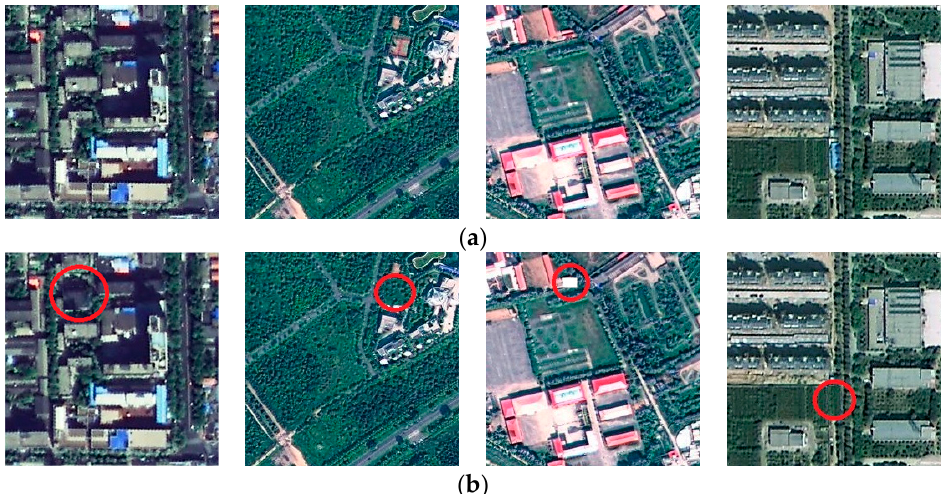
Figure 12. Tampering examples of appending object: ( a ) Original HRRS images, ( b ) corresponding tampered images.